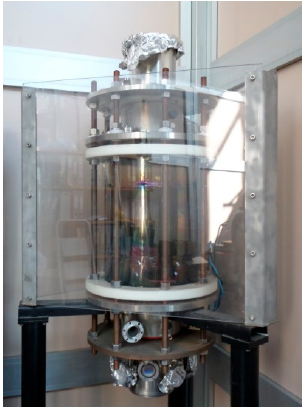
Figure 5. The PROTO ‐ PINCH vacuum vessel. Figure 5. The PROTO-PINCH vacuum vessel.